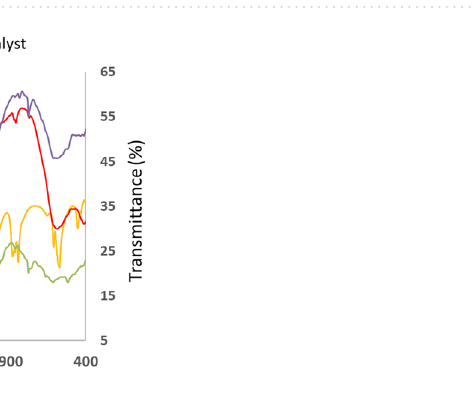
Figure 2. Schematic preparation of SSE@GO-CuFe 2 O 4 nanocomposite.